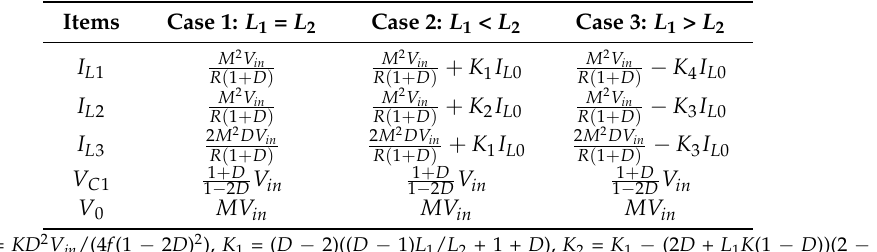
Table 1. DC equilibrium points of proposed step-up converter.